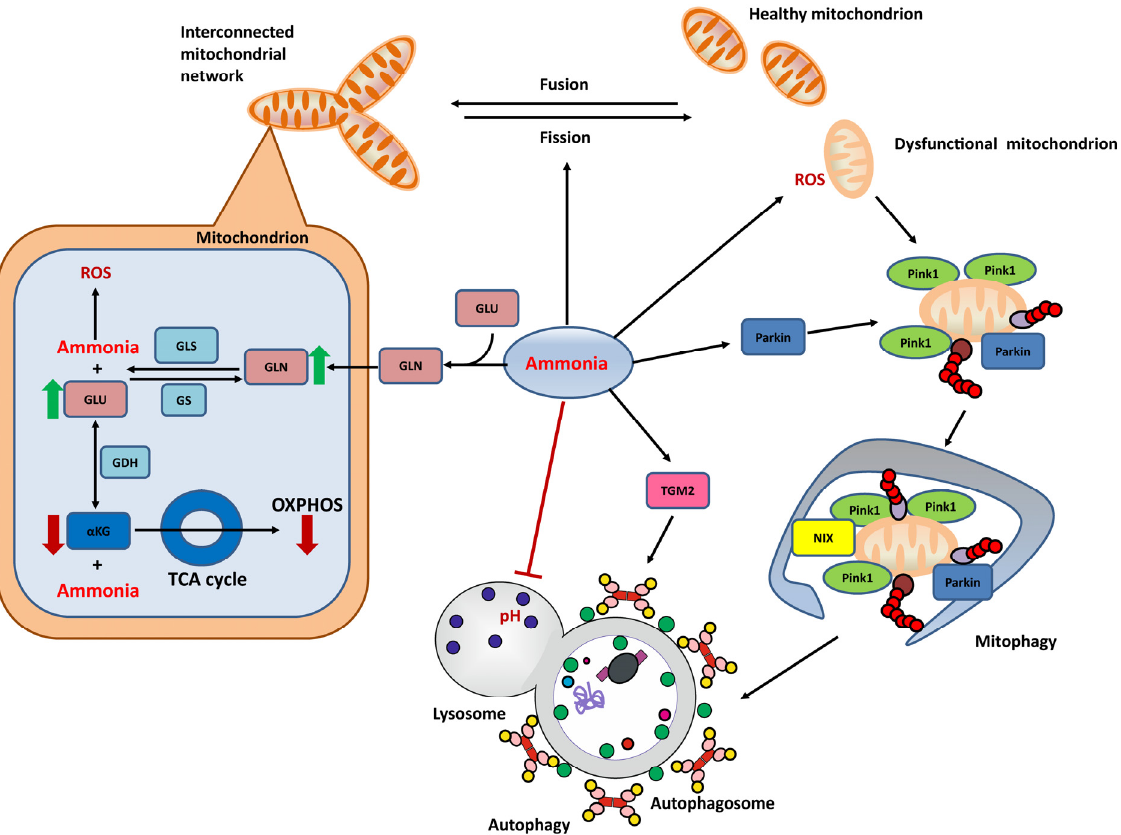
Figure 2. Major mitochondria-related pathogenesis mechanisms induced by ammonia toxicity in astrocytes. In the pathogenesis of HE, hyperammonemia directly affects mitochondrial function in astrocytes. One possible explanation is the “Trojan horse” hypothesis: transport of glutamine into mitochondria leads to the subsequent generation of ROS and ammonia inside mitochondria. Ammonia also leads to a dramatic increase in the synthesis of glutamine and glutamate and thus a partial depletion of α KG, which further decreases the capacity of oxidative phosphorylation. An increase in mitochondrial dysfunction naturally activates a variety of mQC processes. For mitochondrial dynamics, ammonia increases mitochondrial fission. For mQC degradation pathways, on the one hand, ammonia enhances mitophagy initiation, for example, via a ubiquitination-mediated pathway; on the other hand, ammonia blocks the late stages of autophagic degradation via pH alteration, which in turn promotes relevant defense mechanisms such as TGM2 upregulation. α KG: α - ketoglutarate; GDH:glutamate dehydrogenase; GLN:glutamine; GLS:glutaminase; GLU:glutamate; GS:glutamine synthetase; OXPHOS:oxidative phosphorylation; ROS:reactive oxygen species.